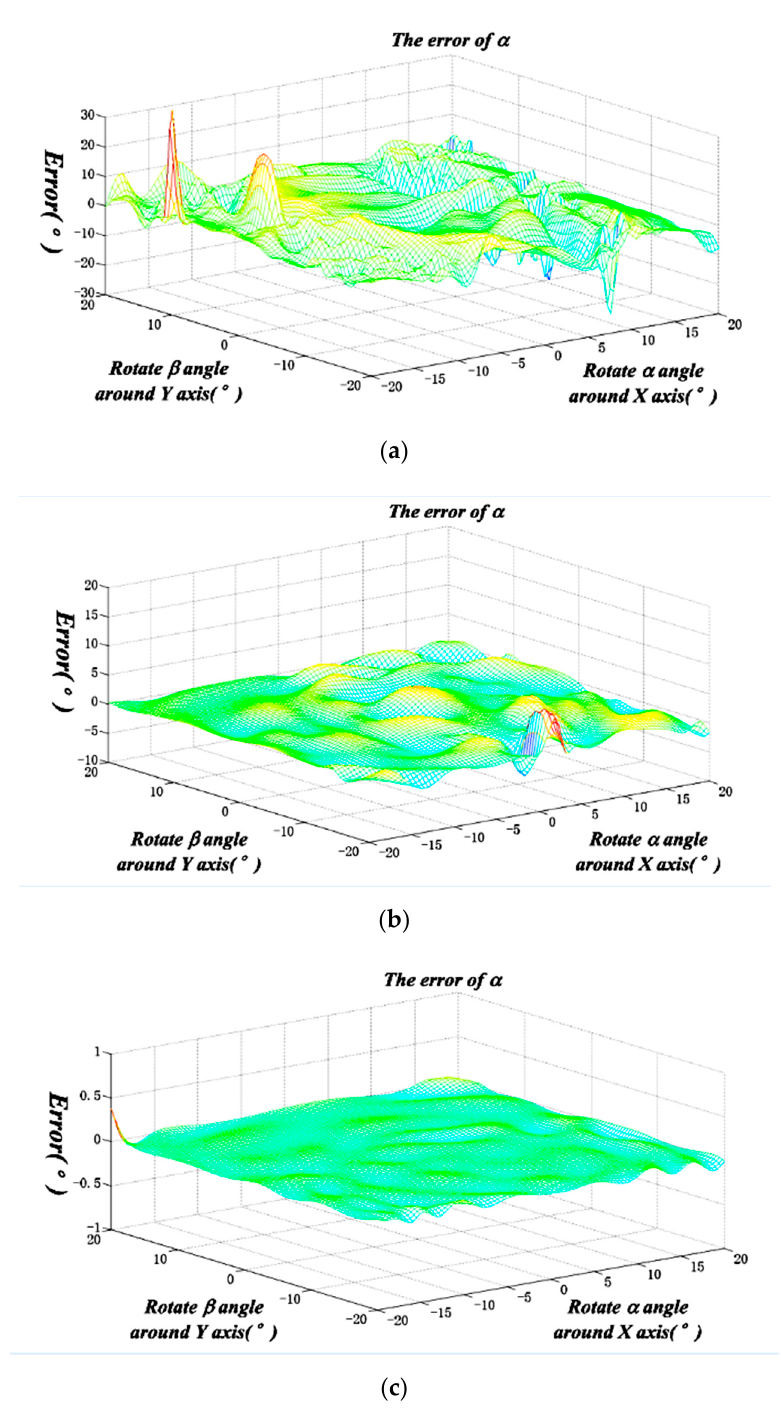
Figure 3. Output error diagrams of BP artificial neural network (ANN) with different numbers of sensors. ( a ) Diagram of three-input error; ( b ) diagram of four-input error; ( c ) diagram of five-input error.